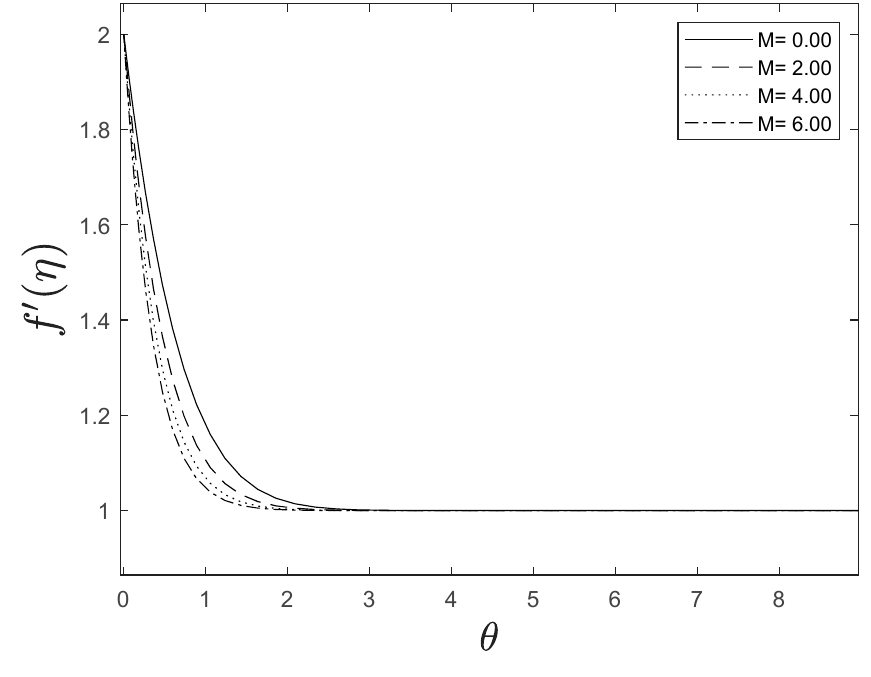
Figure 2. Effect of different values of M on f (cid:48) ( η ) .